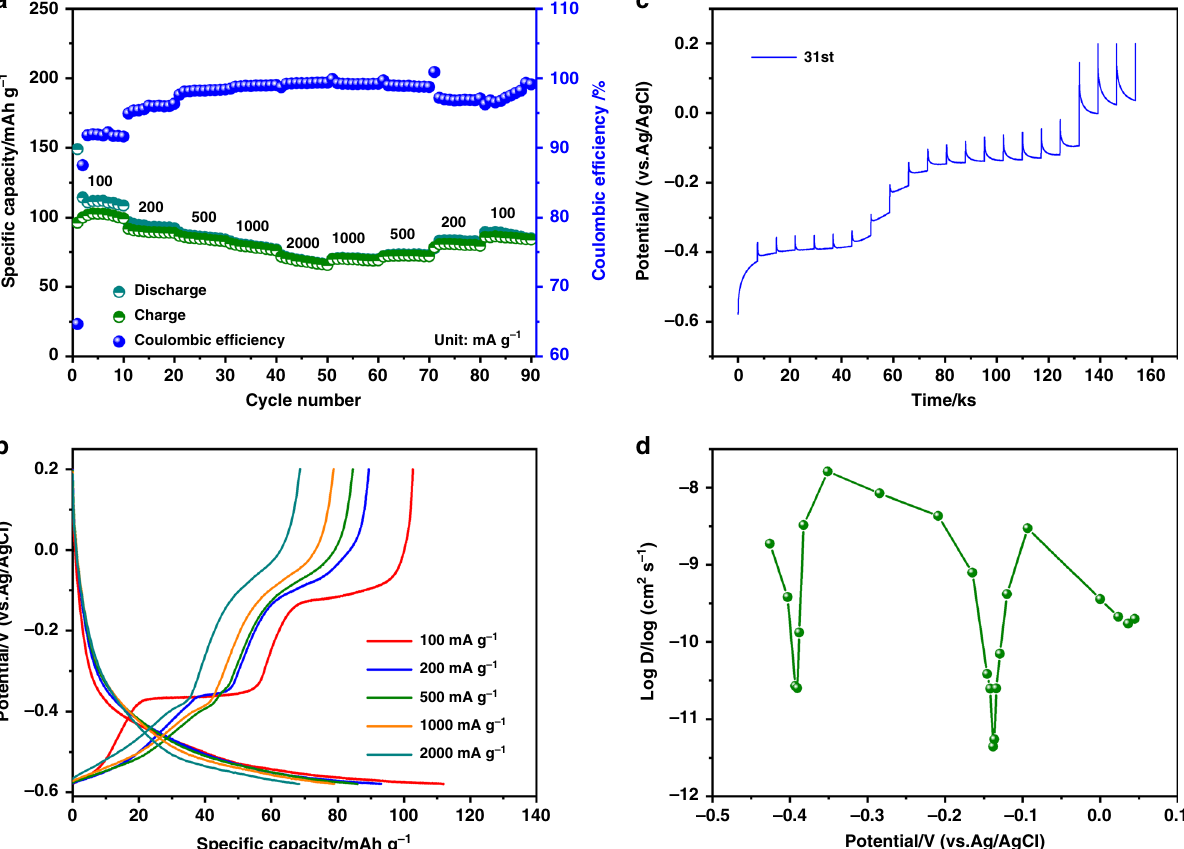
Fig. 8 Rate performance and the reaction kinetics. a Rate performance and CE of MV 2 + storage in PTCDA from 100 mA g − 1 to 2000 mA g − 1 ; b The GCD potential pro fi les of the PTCDA electrode tested at different current rates; c The GITT potential pro fi le of the PTCDA electrode in the 31st charge process; d Diffusion coef fi cients calculated from the GITT potential pro fi les as a function of SOC during the 31st charge Fig. 8a, at a high current rate of 2000 mA g − 1 , a speci fi c capacity increases, the onset potential of HER is lowered due to polar- of 66.7 mAh g − 1 can still be retained, and the shape of the GCD ization, thus inhibiting HER from taking place and raising the CE potential pro fi les can be well retained upon increasing the current to nearly 100%. Interestingly, the rate performance of storing rate (Fig. 8b). These features suggest fast transport of MV 2 + in MV 2 + in PTCDA is comparable with that of hosting metal-ions the cells despite MV 2 + ’ s large size. Note that the disparity in the and ammonium-ions, as shown in Supplementary Figs. 16 and 17, which again indicates the good kinetics of MV 2 + (de) CE under different current rates can be attributed to the extents intercalation. of the HER on the PTCDA electrode. As the current rate NATURE COMMUNICATIONS| (2019) 10:3227